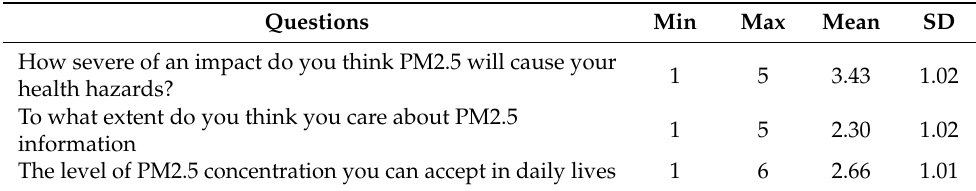
Table 5. Descriptive statistics of subjects’ attitude towards